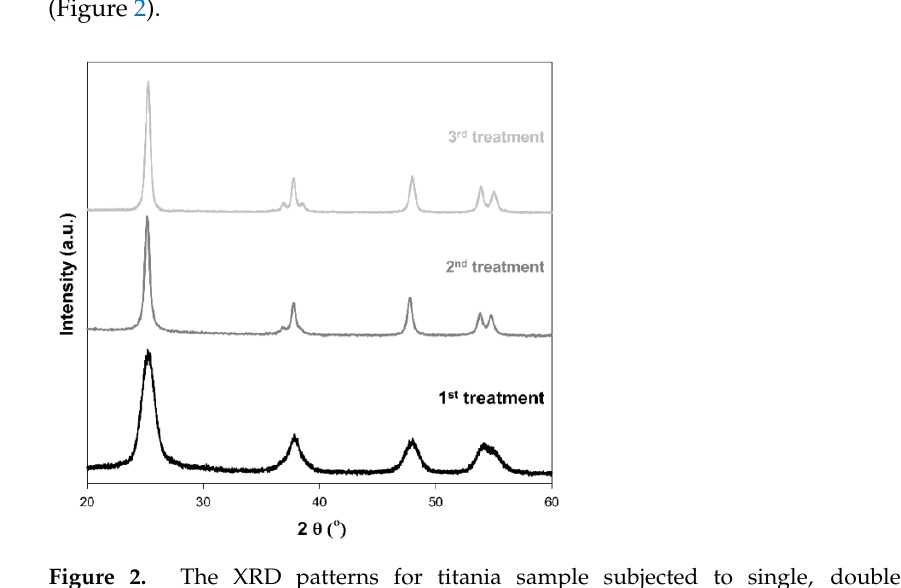
Figure 2. The XRD patterns for titania sample subjected to single, double, and triple microwave treatment.